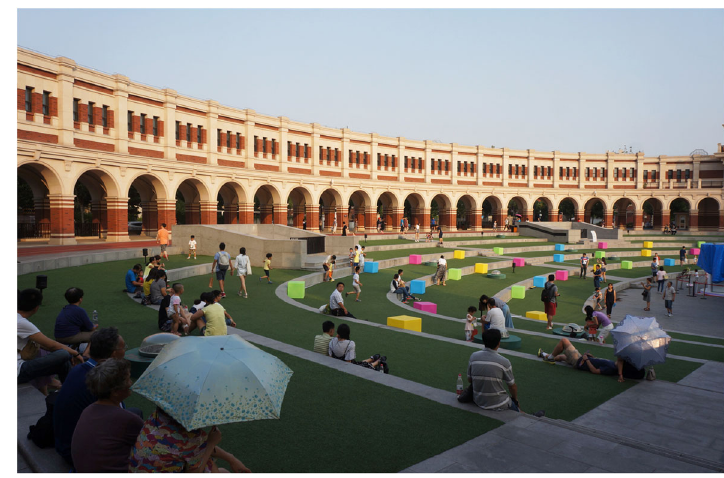
Fig. 10 Minyuan Stadium in Wudadao area (Source: Yue Lu, 2019)